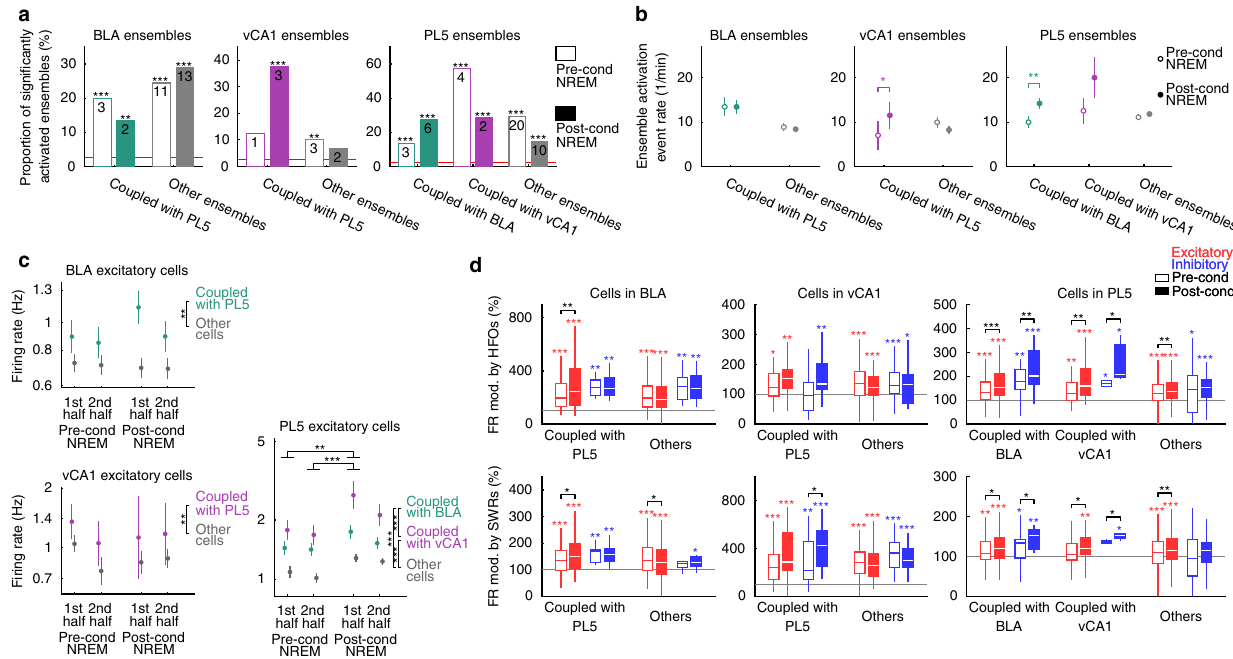
Fig. 9 Coactivation-participating-ensembles in the BLA and PL5, and the distinct fi ring properties of ensemble-coactivation-contributing cells in the BLA and vCA1 are con fi gured prior to conditioning. a The proportion of ensembles signi fi cantly activated during pre- and post-cond NREM. Ensembles not coupled with PL5, BLA, or vCA1 are shown as other ensembles. The horizontal line indicates the chance level (2.5%), and the numbers of ensembles are superimposed on the bars. *** p < 0.001, ** p < 0.01, χ 2 test. b Mean ensemble activation event rates in NREM. Ensembles not coupled with PL5, BLA, or vCA1 are shown as other ensembles. Error bars indicate the SEM. ** p < 0.01, * p < 0.05, WSR-test for difference between pre- and post-cond NREM. c Mean fi ring rates of coupled and non-coupled (others) excitatory cells during NREM in the 1st and 2nd halves of pre- and post-cond homecage sessions. Error bars indicate SEM. *** p < 0.001, ** p < 0.01, * p < 0.05, post hoc TK test following two-way ANOVA on the logarithm of the data. The coupled regions had a signi fi cant effect in all regions, whereas periods had a signi fi cant effect in PL5 but not in BLA or vCA1. d The fi ring rate modulation (FR mod.) by HFOs and SWRs ( fi ring-rate ratio of within over outside HFOs or SWRs during NREM) for coupled and non-coupled (others) cells in the BLA, vCA1, and PL5. The centre lines and limits of the boxes represent the median and upper/lower quartiles, respectively, and whiskers extend to the maxima and minima with cond NREM (coloured) and changes from pre- to post-cond NREM (black). The numbers of analysed ensembles in ( a , b ) and cells in ( c , d ) are summarised in Supplementary Tables 7 and 8, respectively. Detailed statistics are shown in Supplementary Data 1. Source data are provided as a Source Data fi